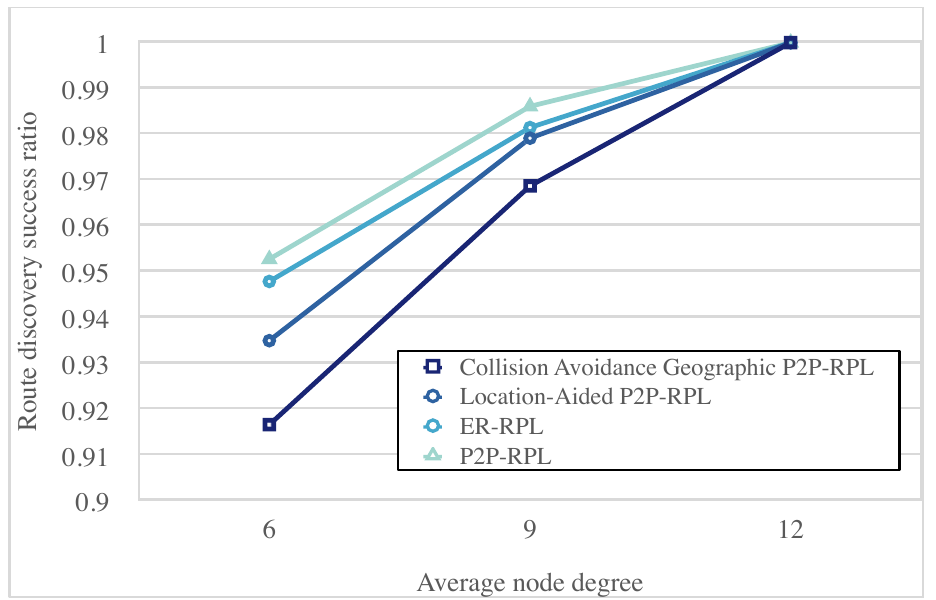
Figure 12. The route discovery success ratio versus the average node